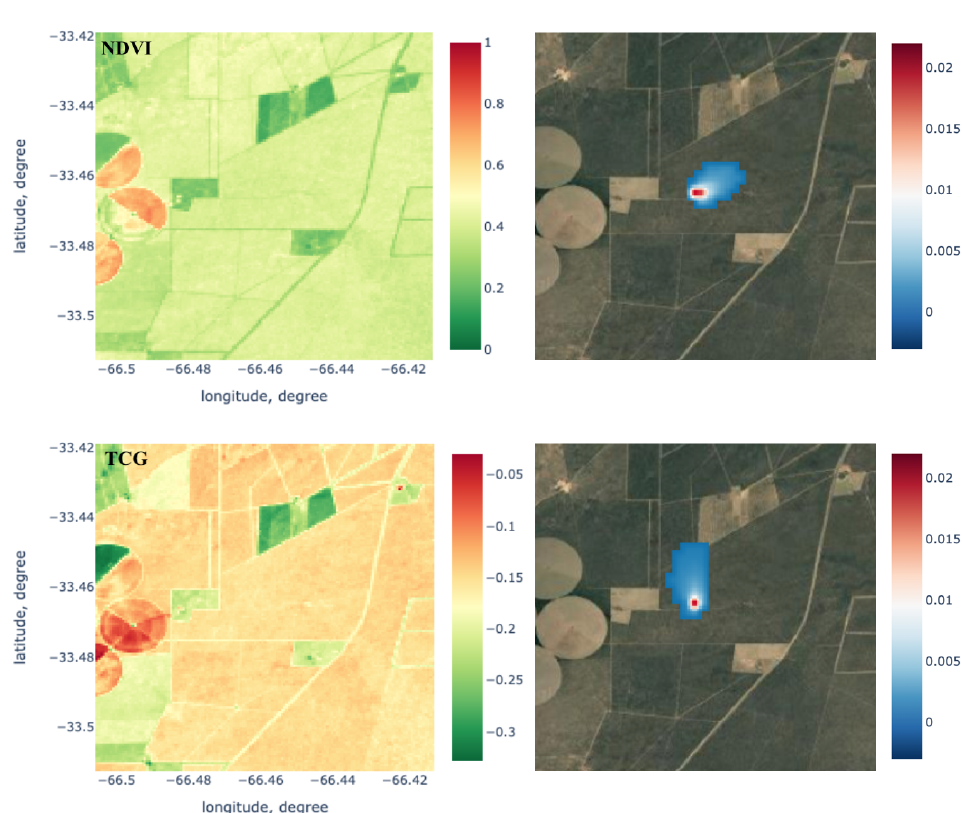
Figure 3. Left panels are maps of calculated indices for the same date; right panels are maps of daily weight functions for different